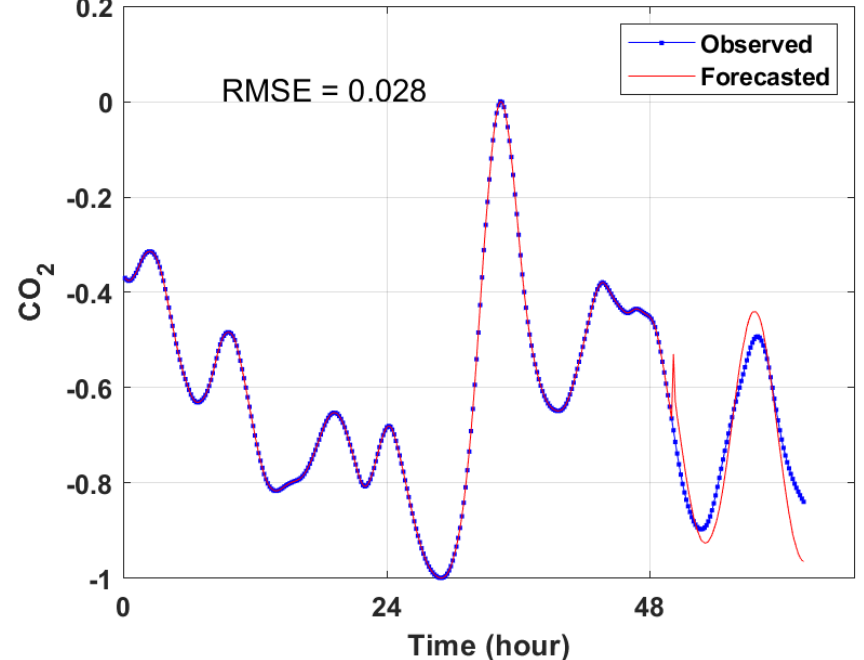
Figure 9. CO 2 forecasting by LSTM.